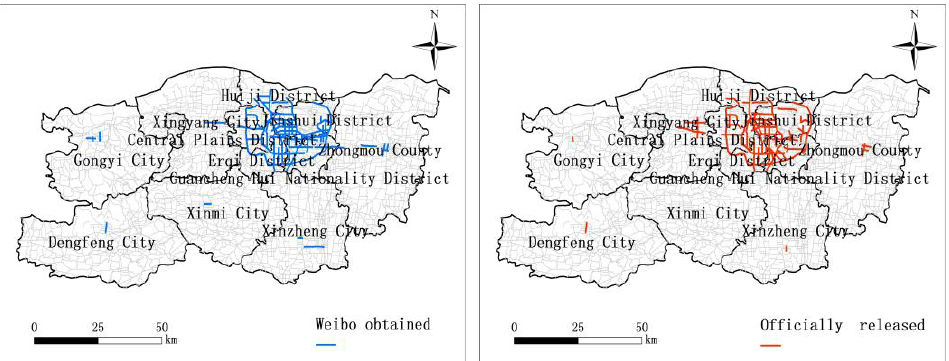
Figure 4. Waterlogging urban roads’ comparison between Weibo and